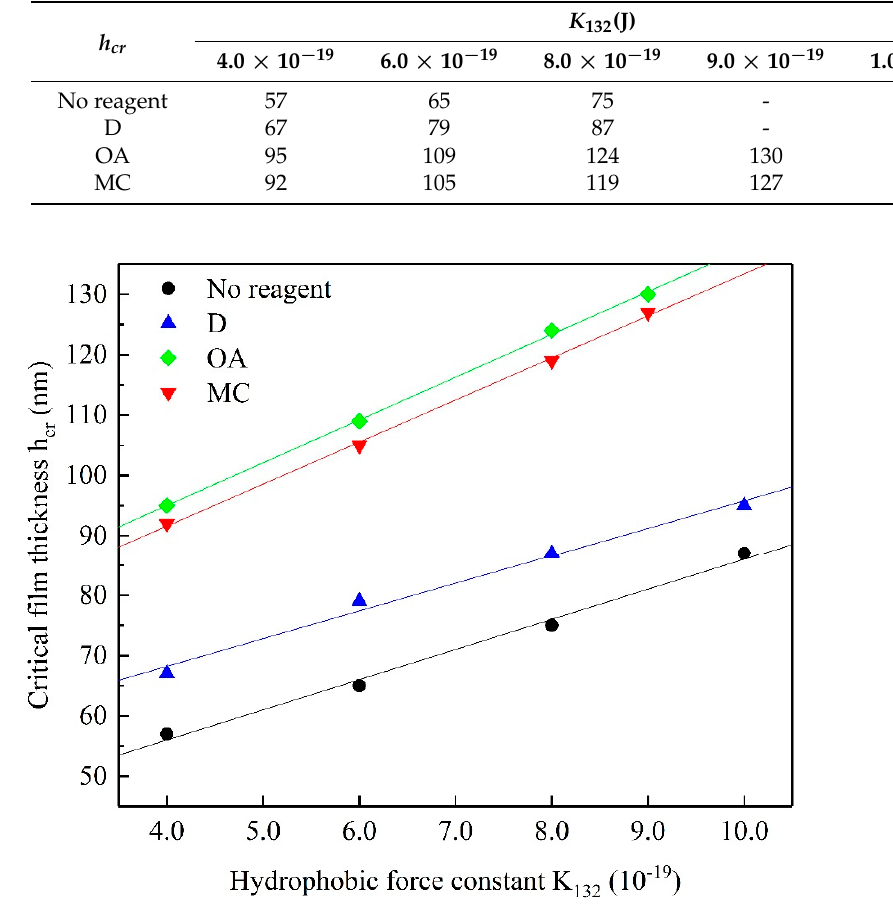
Figure 5. The linear relationship between hydrophobic force constant and critical film thickness.